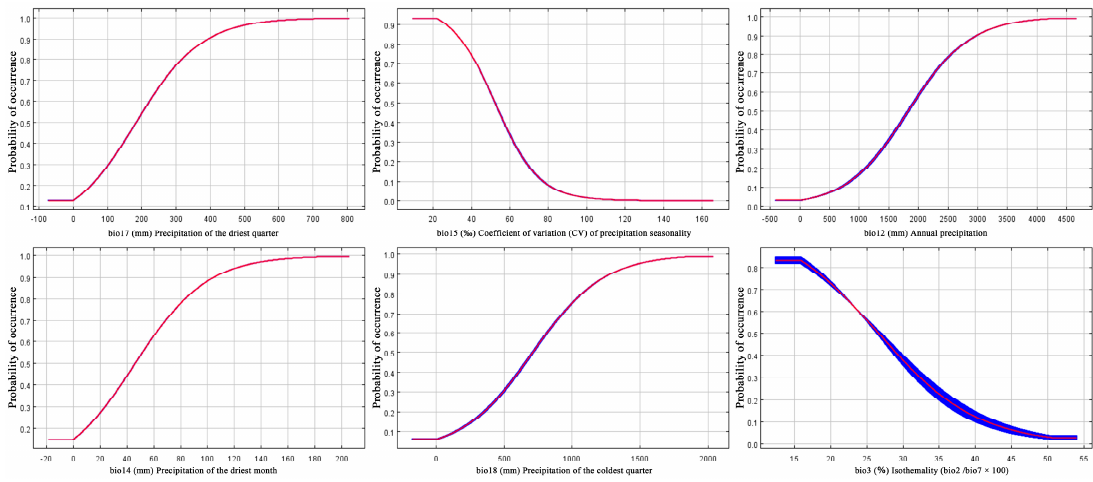
Figure 4. Response curves of the major climate factors.